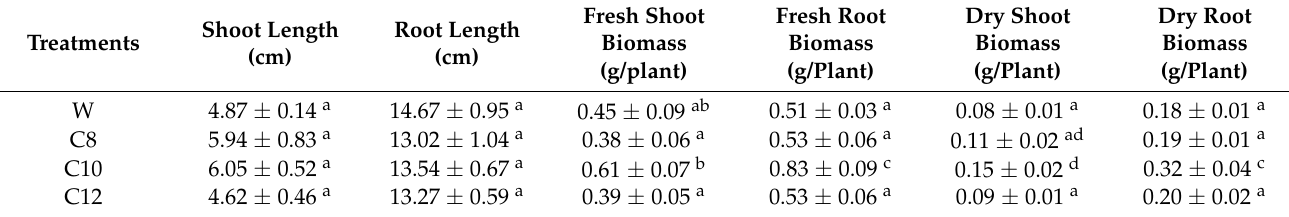
Table 1. Comparison of plant growth parameters using the root, shoot length, wet, and dry biomass contributed by N -acyl homoserine lactone treatments.